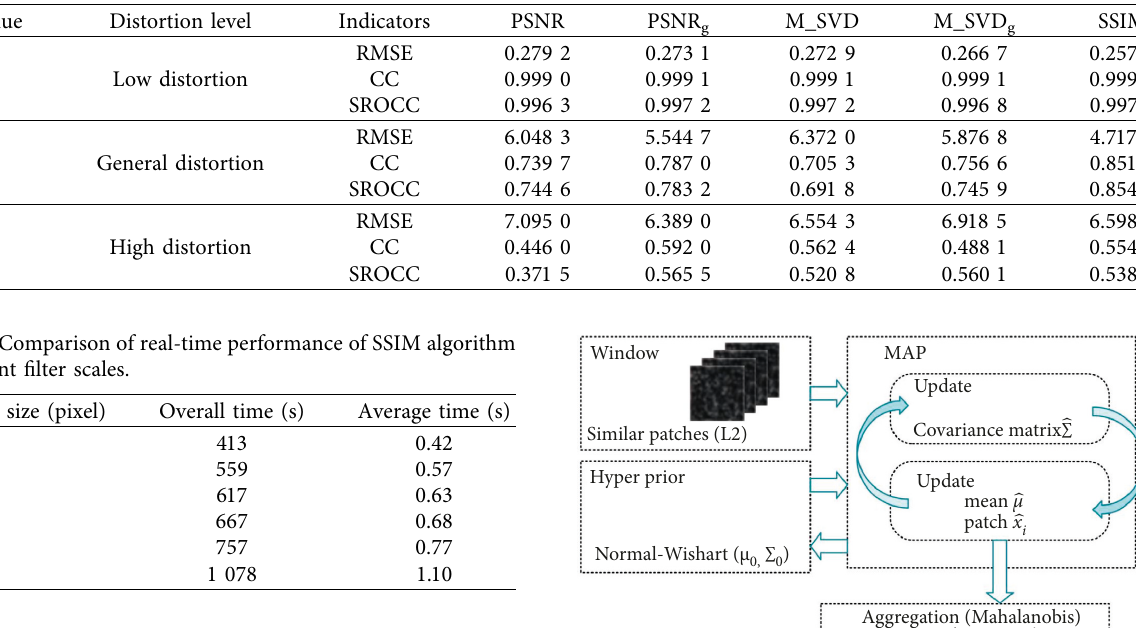
Table 2: Evaluation results of algorithms based on different image distortion levels.